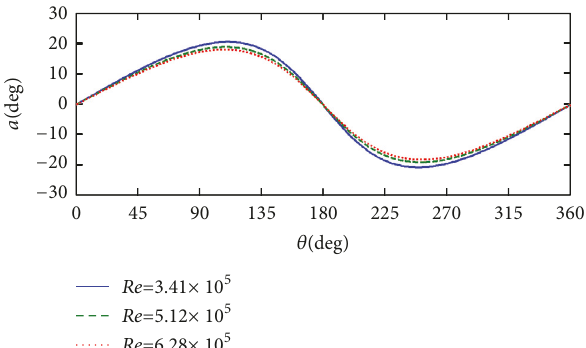
Figure 9: Angle of attack versus azimuth for different Reynolds number, at 𝜓 =0.25.